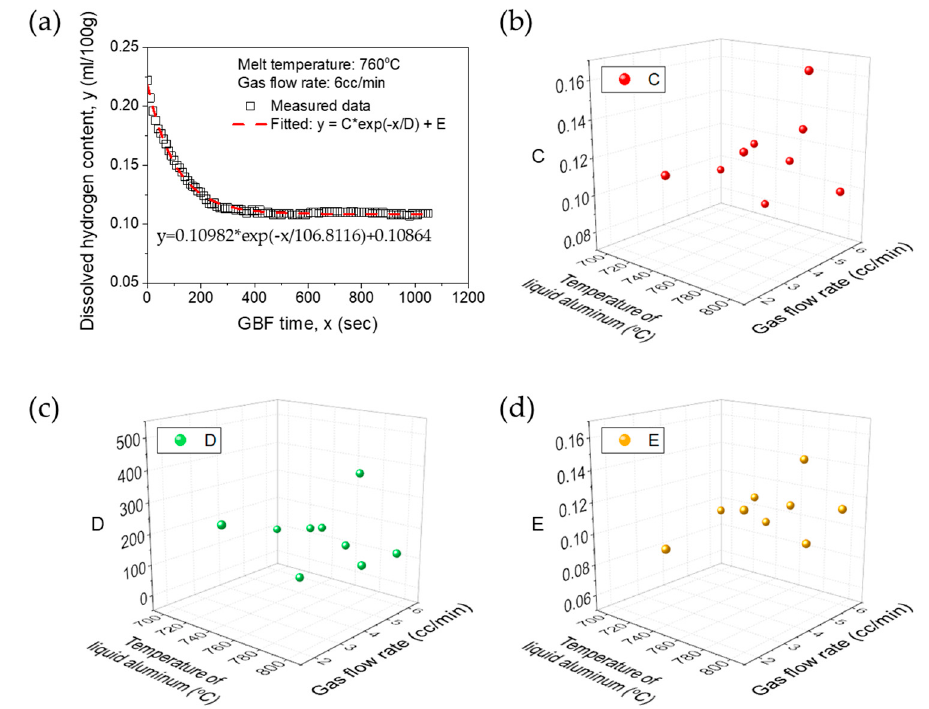
Figure 10. ( a ) Numerical fitting of measured value (one example of experimental results: temperature of liquid aluminum 760 ° C, gas flow rate 6 cc/min). Fitted parameters of ( b ) C, ( c ) D, and ( d ) E depending on temperature of liquid aluminum and gas flow rate.